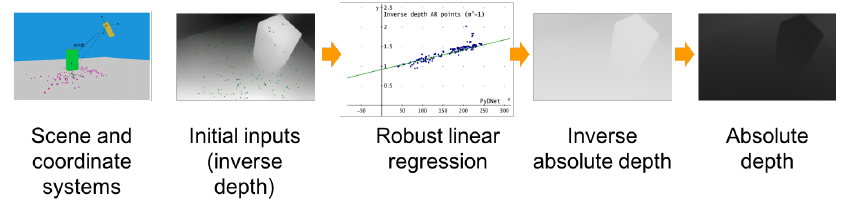
Figure 7. Augmented Reality (AR) pipeline. The leftmost figure depicts an object (green box) framed by a device (yellow box) capable of providing sparse absolute depth points (in purple) through the AR framework and a dense inverse depth map thanks to the monocular network. To realize our improved AR application, we move first sparse depth measurements into the inverse depth domain (second image from the left). Then, we obtain the shift and scale factor that maps such sparse points and corresponding predictions picked by the dense inverse map provided to the network by robustly regressing a linear model within a RANSAC framework, as illustrated in the chart. Finally, we scale the dense inverse map accordingly before turning back into the depth domain (respectively, the two rightmost maps) to render virtual objects consistent with the inferred geometry of the